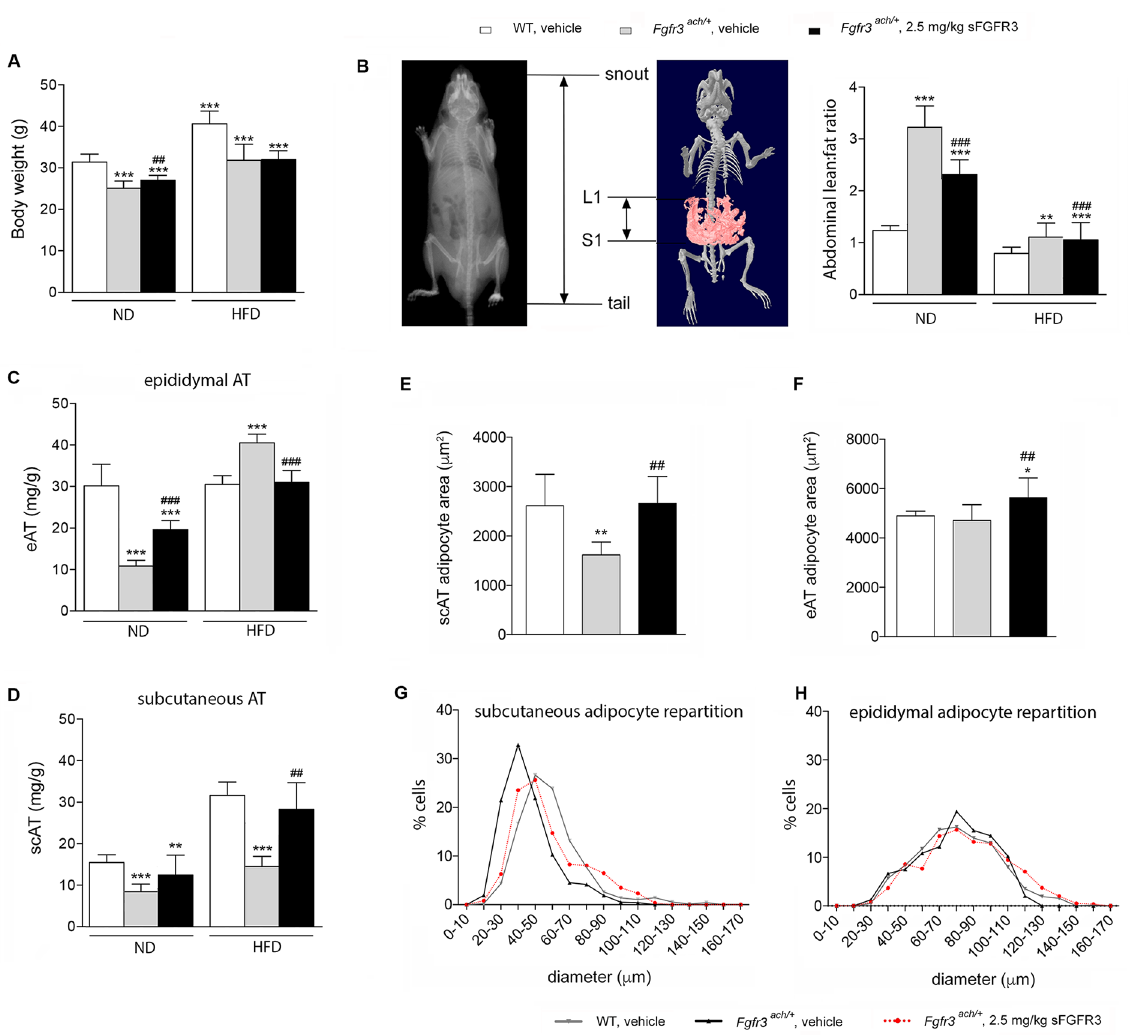
Fig 2. Transgenic Fgfr3 ach/+ mice preferentially develop visceral obesity that is prevented upon sFGFR3 treatment. ( A ), body weight of vehicle-treated WT and Fgfr3 ach/+ mice and sFGFR3 treated Fgfr3 ach/+ mice after 10 weeks of ND or HFD challenge. ( B ), abdominal lean:fat ratio. ( C ) epididymal adipose tissue (eAT) weight and ( D ) subcutaneous adipose tissue (scAT) weight per g of body weight. ( E ) scAT and ( F ) eAT adipocyte area ( μ m 2 ). ( G ) scAT and ( H ) eAT scattering of adipocytes according to their diameter. Data are represented as mean ± SD (n = 8–10 mice to each group). Data followed normal distribution. (cid:3) p < 0.05, (cid:3)(cid:3) p < 0.01, (cid:3)(cid:3)(cid:3) p < 0.001 versus vehicle-treated WT, # p < 0.05, ## p < 0.01 versus vehicle-treated Fgfr3 ach/+ ; Student’s t test.